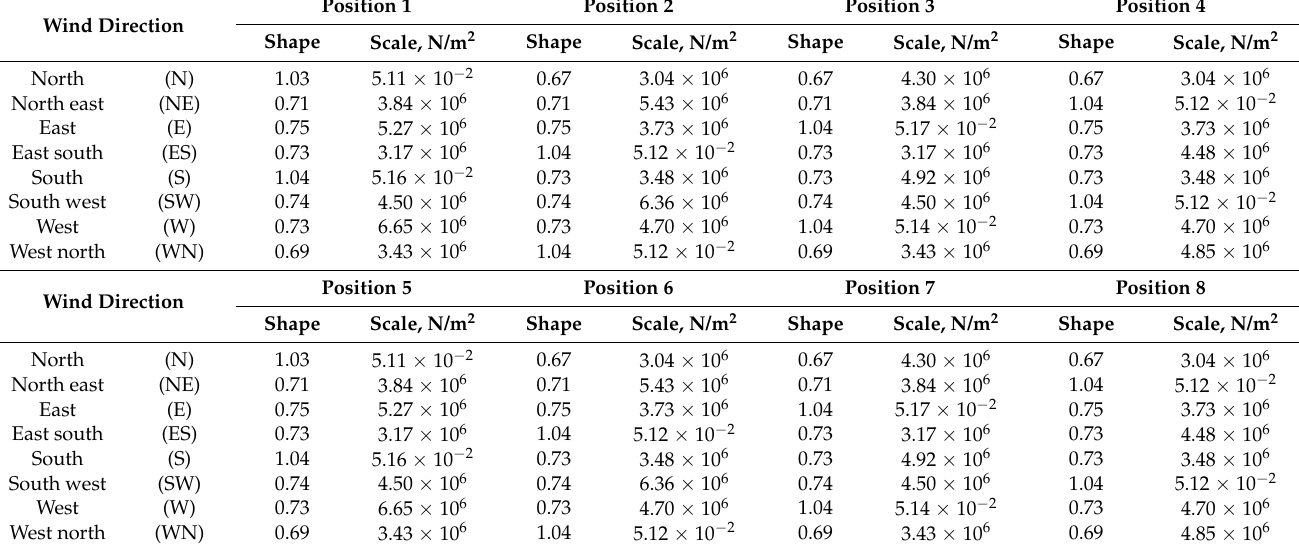
(cid:17) , depending on the wind